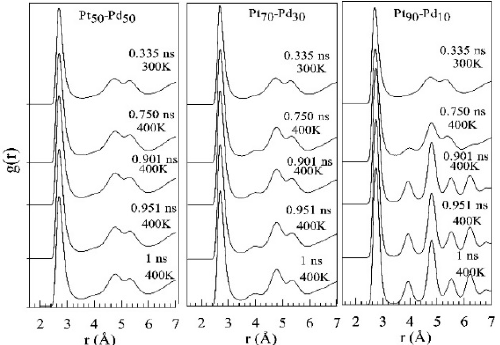
Figure 3. RDF curves obtained at different times and for different temperatures of the process at 300 and 400 K.